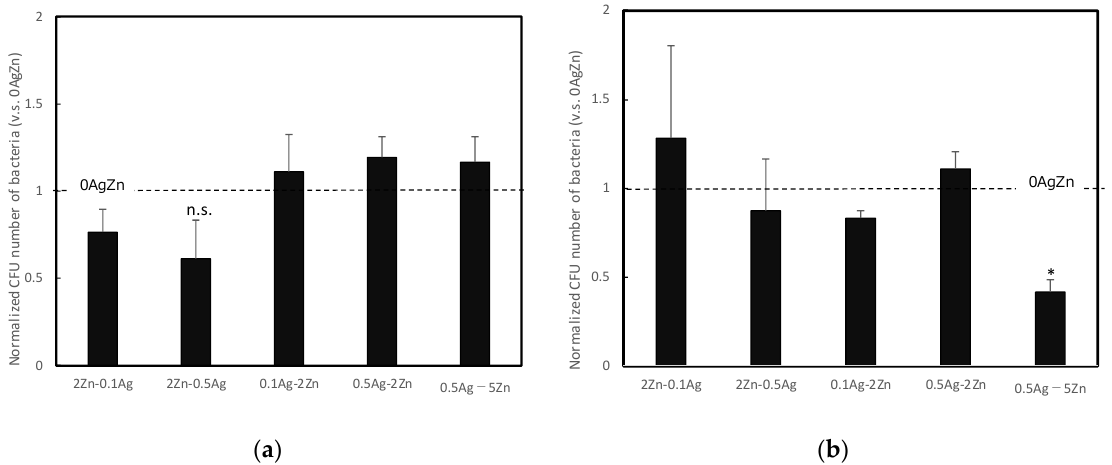
Figure 9. Antibacterial properties of MAO-treated specimens containing both Ag and Zn against ( a ) E. coli and ( b ) S. aureus after two months of aging in physiological saline (* statistically significant difference relative to 0AgZn, p < 0.01; n.s.: no significant difference relative to 0AgZn). Measurements were performed on five equally conditioned specimens ( n = 5).